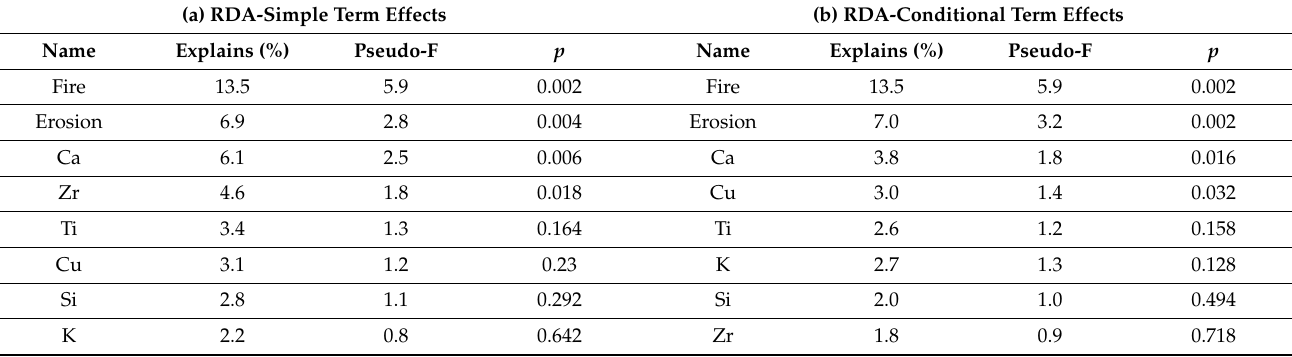
Table 2. The results from the redundancy analysis